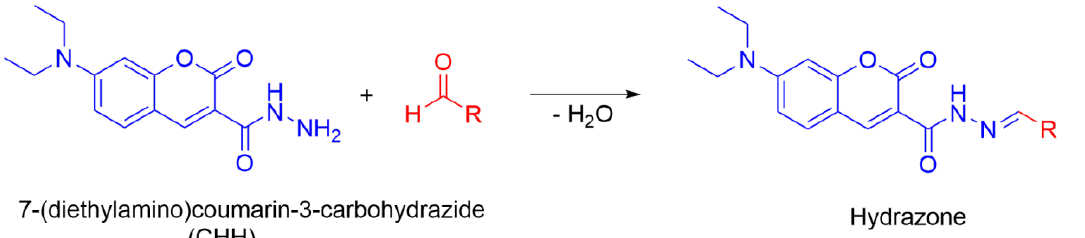
Figure 7. Derivatization reaction of oxidation products of polysorbate with CHH.